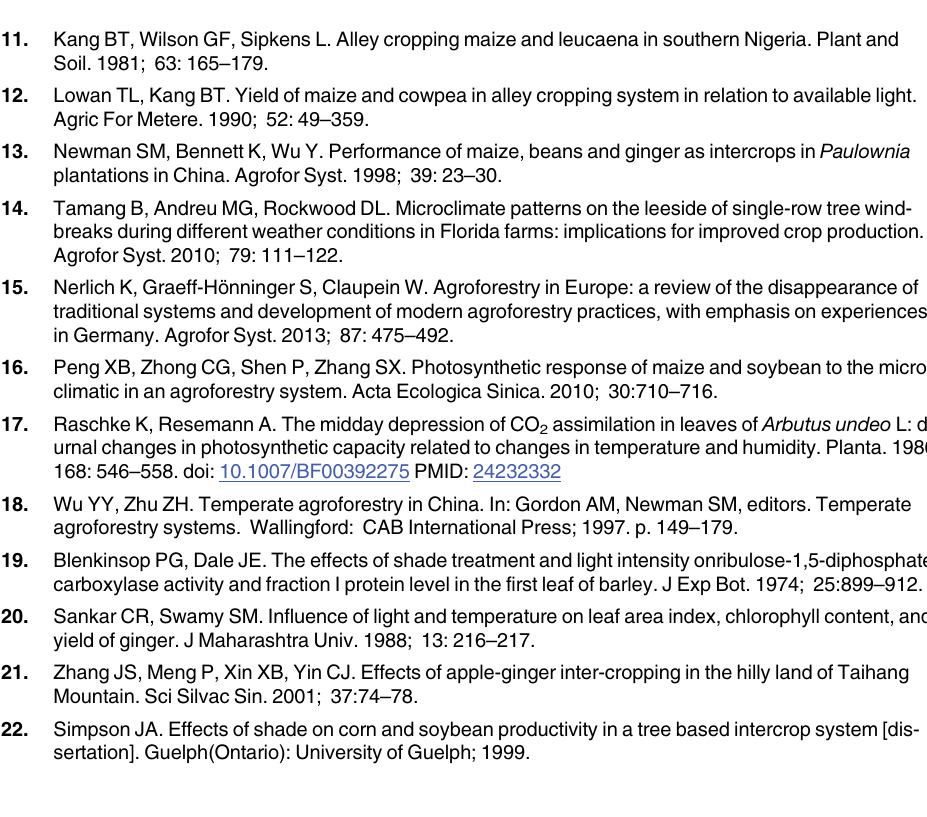
PLOS ONE | DOI:10.1371/journal.pone.0129467 June 8,